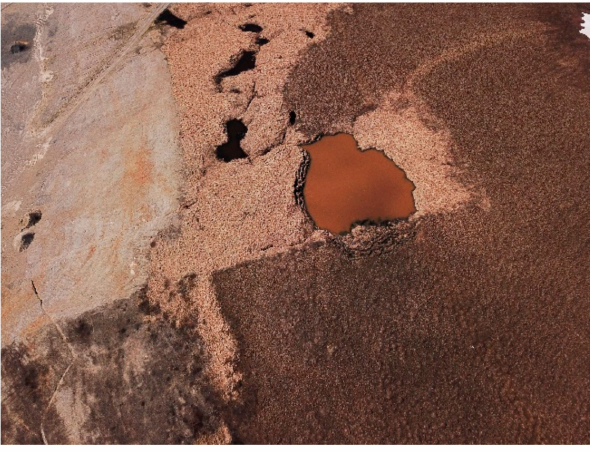
Figure A2. Oblique aerial photo of SG on 31 May 2019.